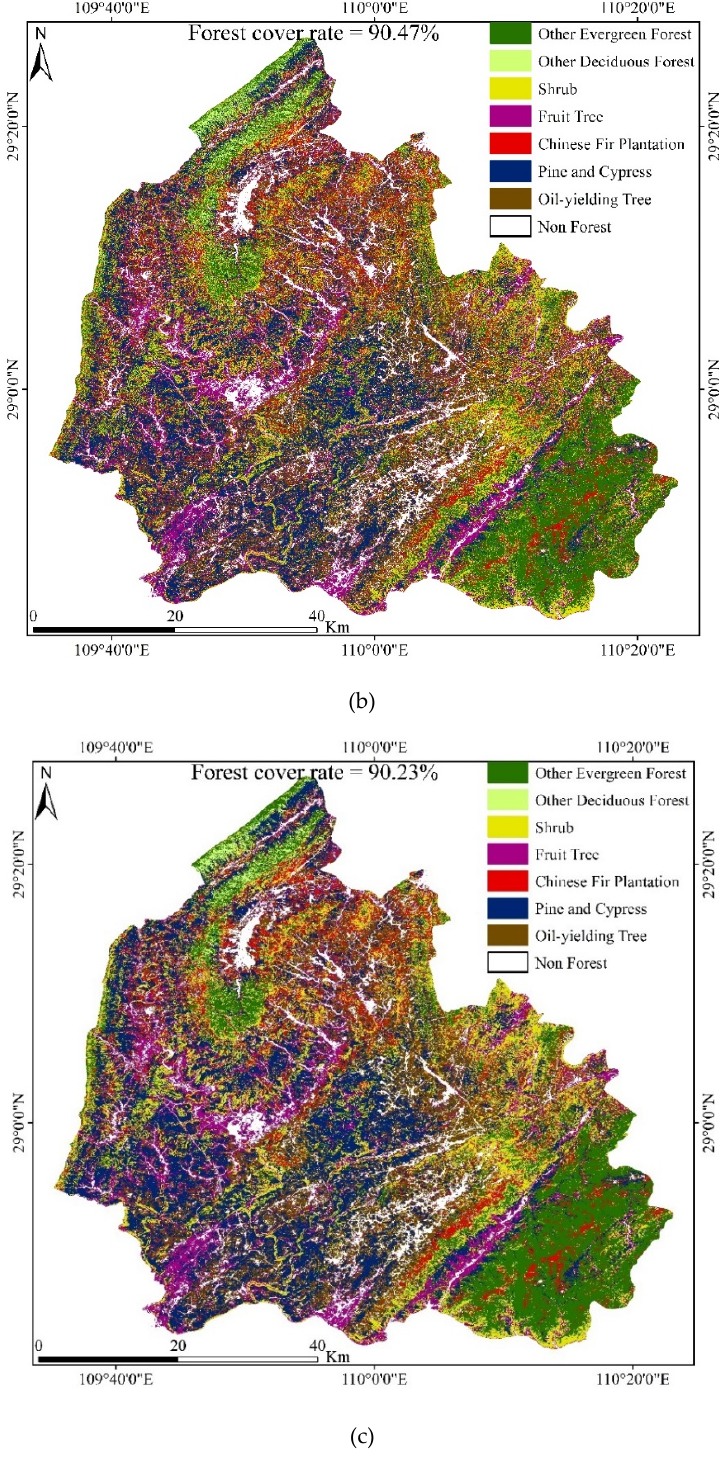
Figure 4. Forest type classification results obtained using TWDTW ( a ), RF ( b ), and SVM ( c ) methods.